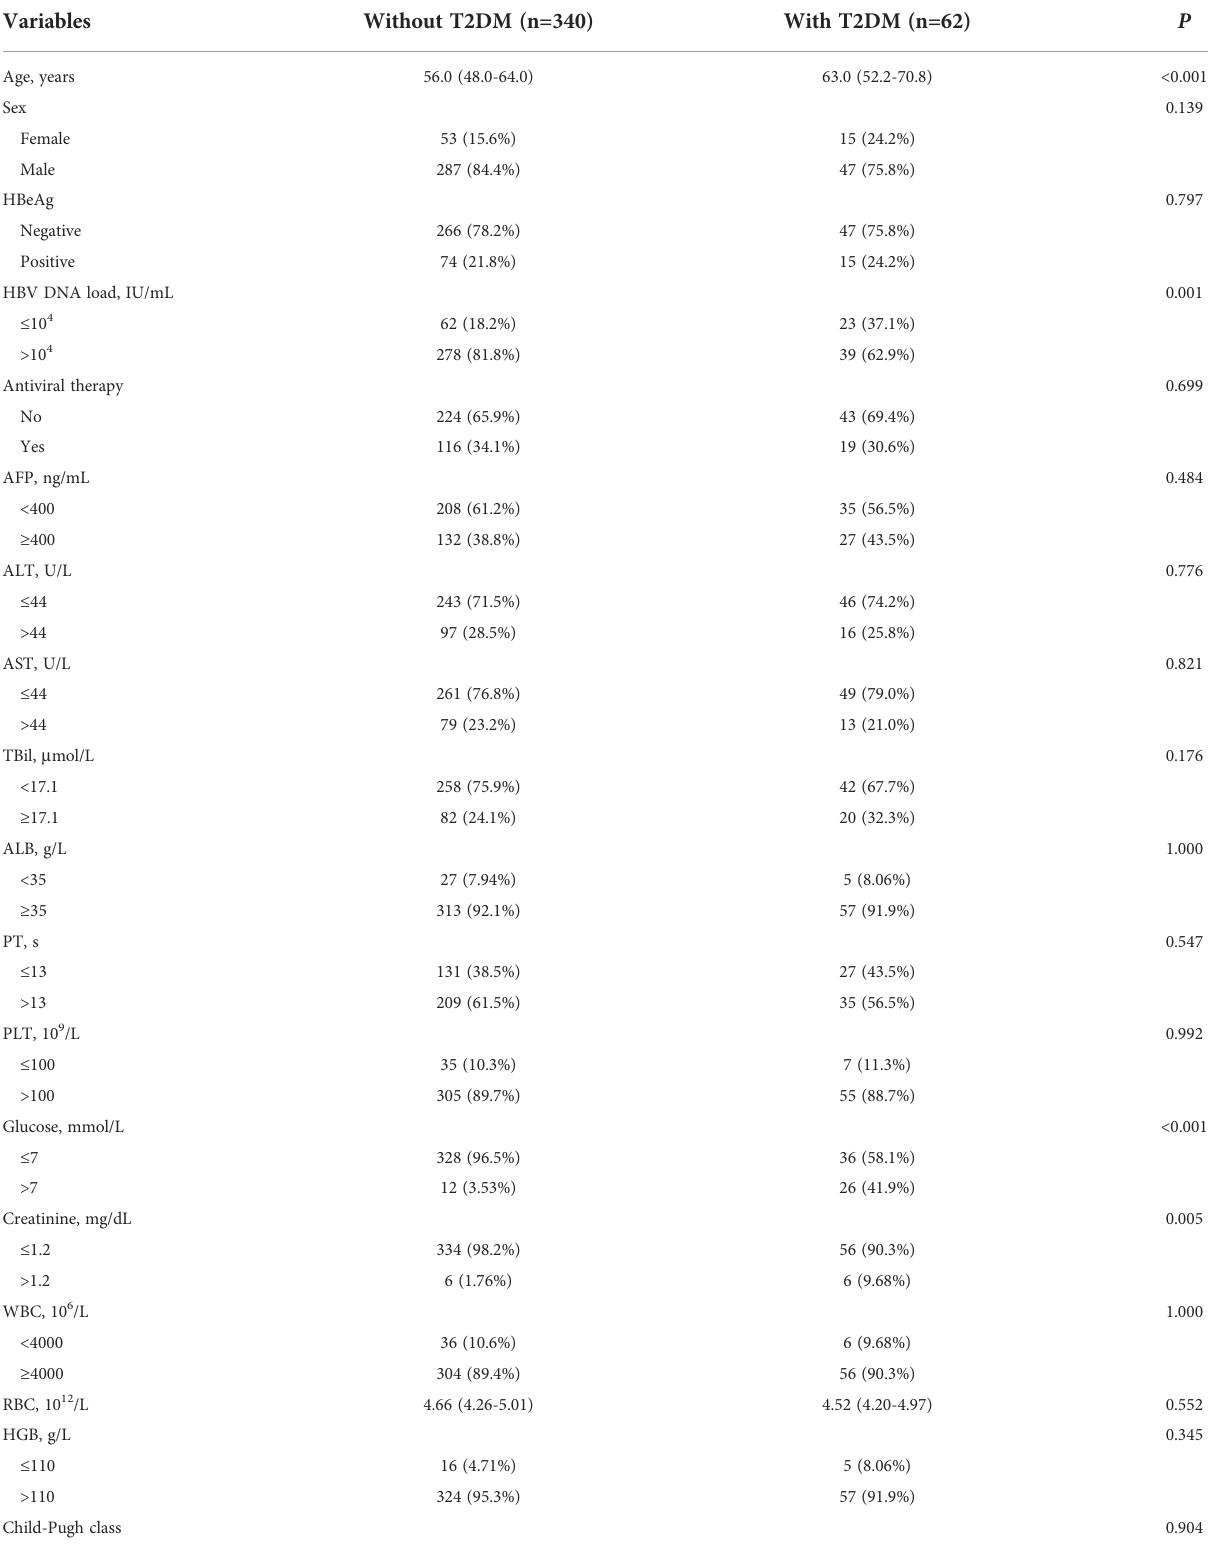
TABLE 1 The baseline clinicopathological features of all HCC patients (n =